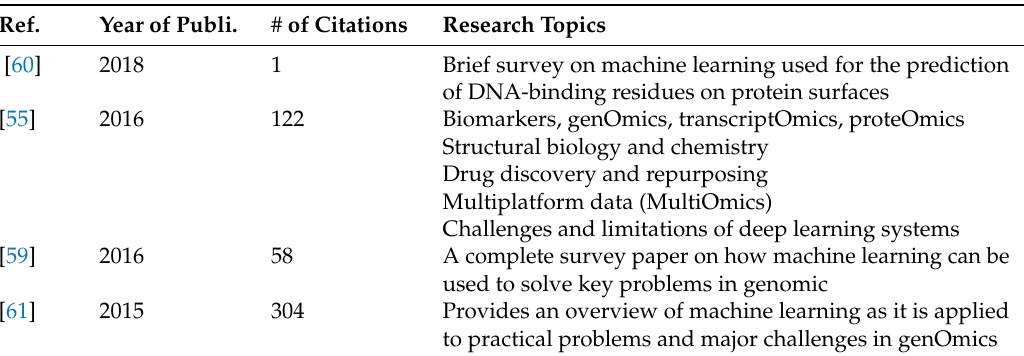
Table 1. Survey papers on deep learning in